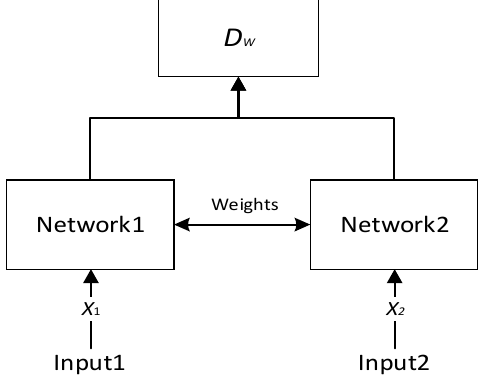
Figure 2. Siamese network structure.